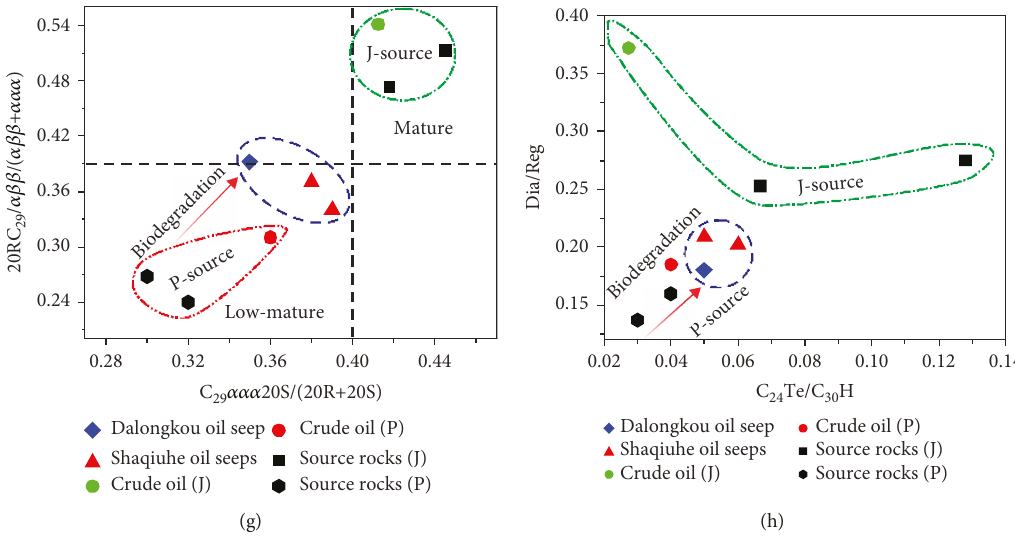
Figure 11: Plots of selected molecular geochemical parameters for oil-seep, crude-oil, and source-rock samples from the eastern segment of the southern and eastern Junggar Basin. (a) δ 13 C (in ‰ relative to the VPDB standard) vs. SA/SARA; (b) C T/C T vs. C T/C T; (d) G/C H vs. Ts/Tm; (e) C (c) C 20 21 21 23 30 ααα 20S/(20R+20S) vs. C αββ /( αββ + ααα ); (h) C (g) C 29 29